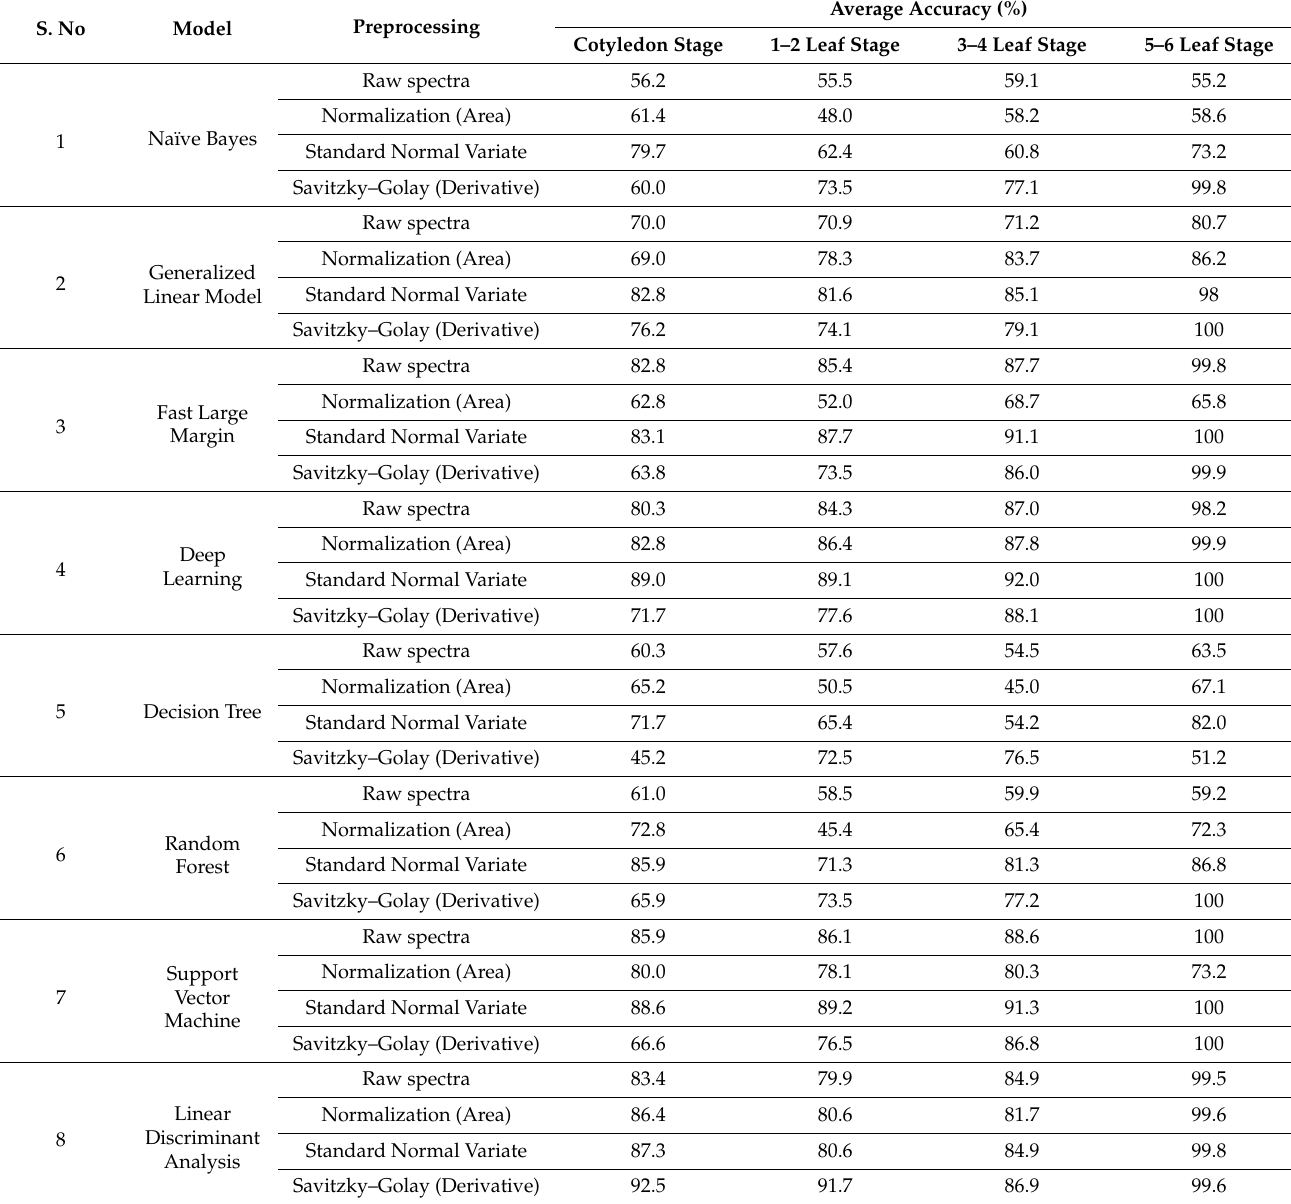
Table 1. Average classification accuracy of the combinations of preprocessing and machine learning methods for reflectance spectra from four different growth stages of eight B. juncea